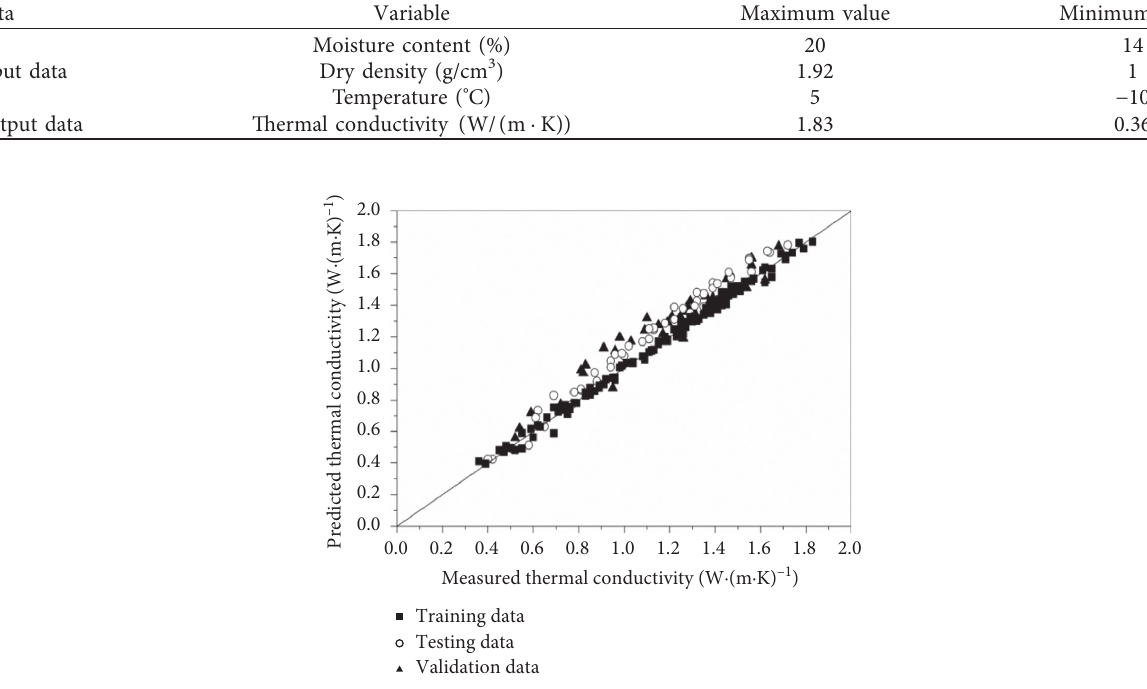
Figure 7: Comparison of the predicted thermal conductivity values of the soil specimens by ANN with the measured thermal conductivity values. Table 5: Comparison of the parameter values of the predicted thermal conductivity results of the model with the measured thermal conductivity results.